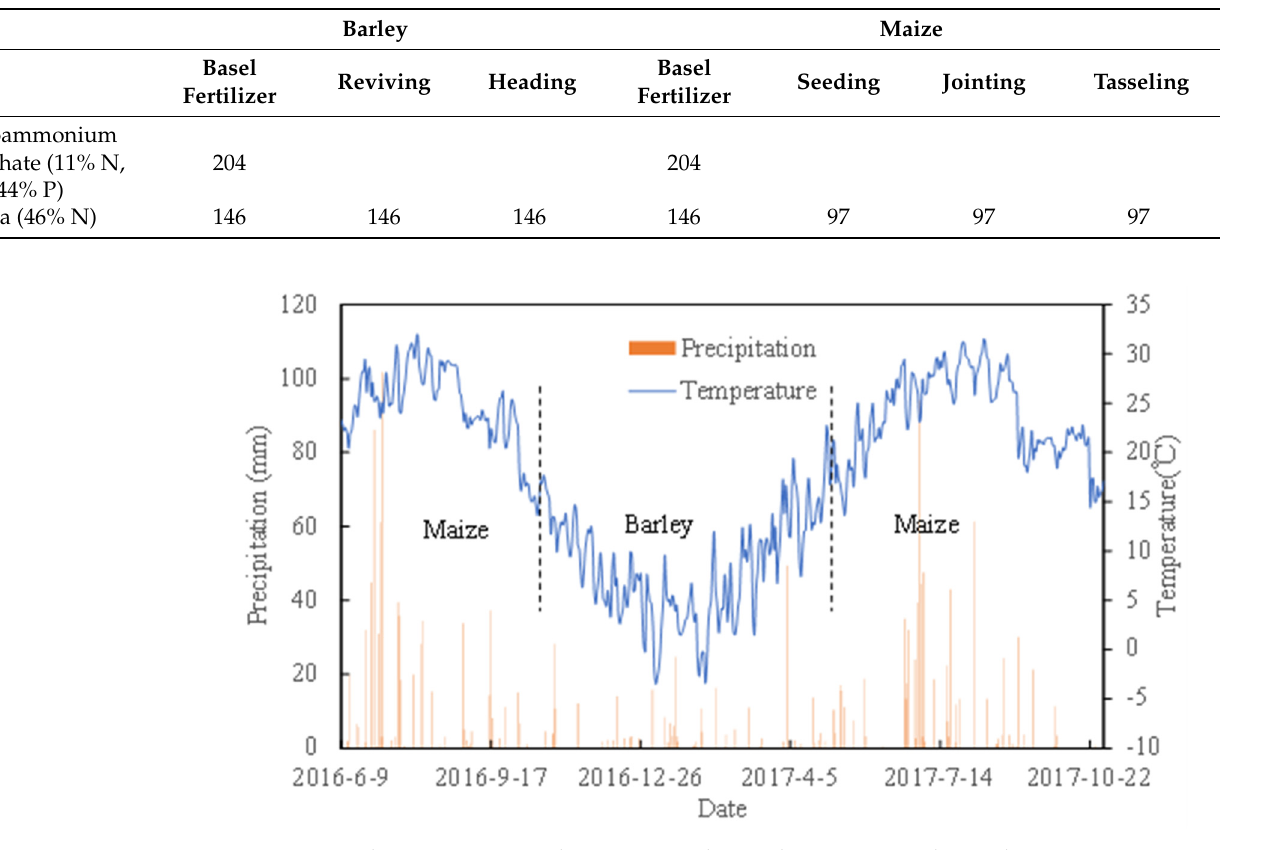
Figure 1. Daily precipitation and temperature during the experimental period. Table 1. Specific fertilization information (kg/ha).